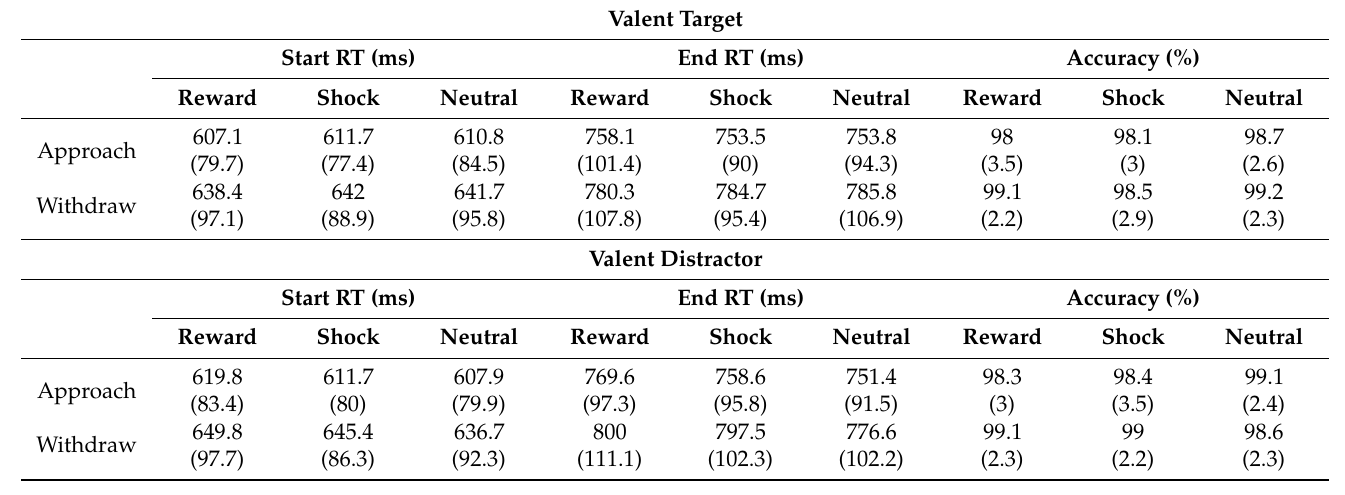
Table 4. Mean start RT, end RT and accuracy for each target type (top) and distractor type (bottom) in the test phase of Experiment 2. Numbers in the parentheses represent the standard